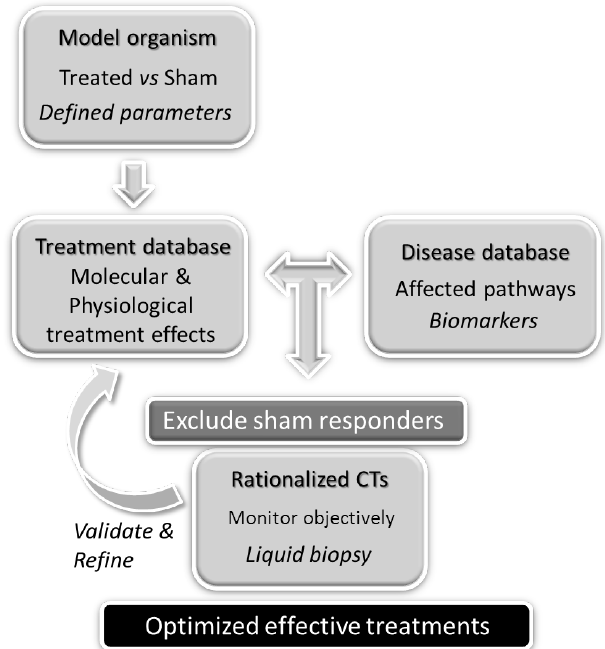
Figure 1. MPTA to define and standardize effective disease-tailored physiotherapy protocols flowchart.